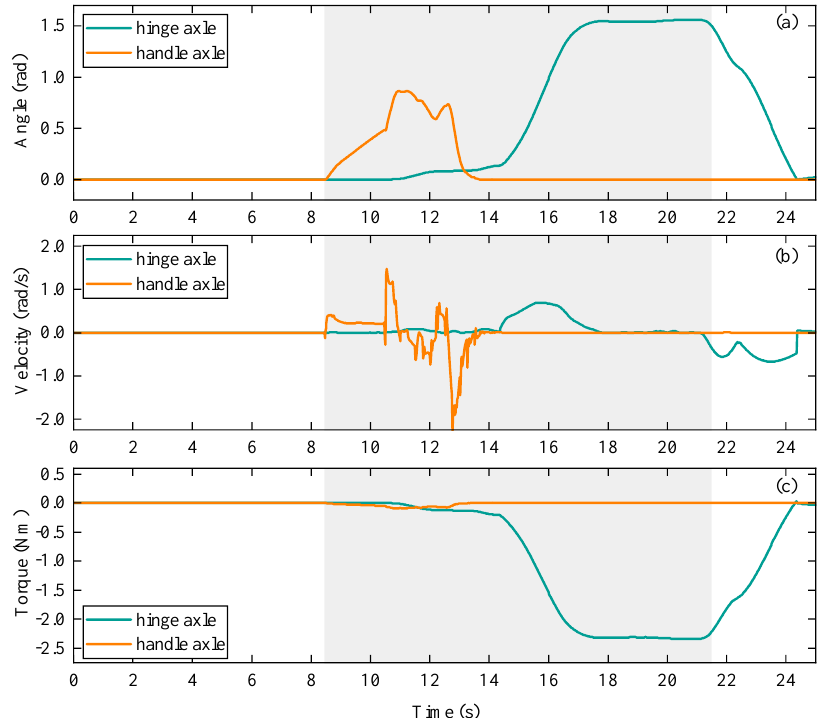
Figure 13. Positions, velocities and resistance torques of door joints. Graphs ( a – c ) are joint angle, velocity and torque. The gray area indicates the time duration of opening the door.